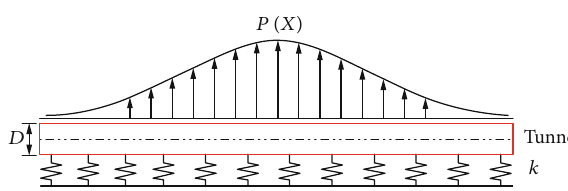
Figure 3: Schematic of calculation model for tunnel response under the additional